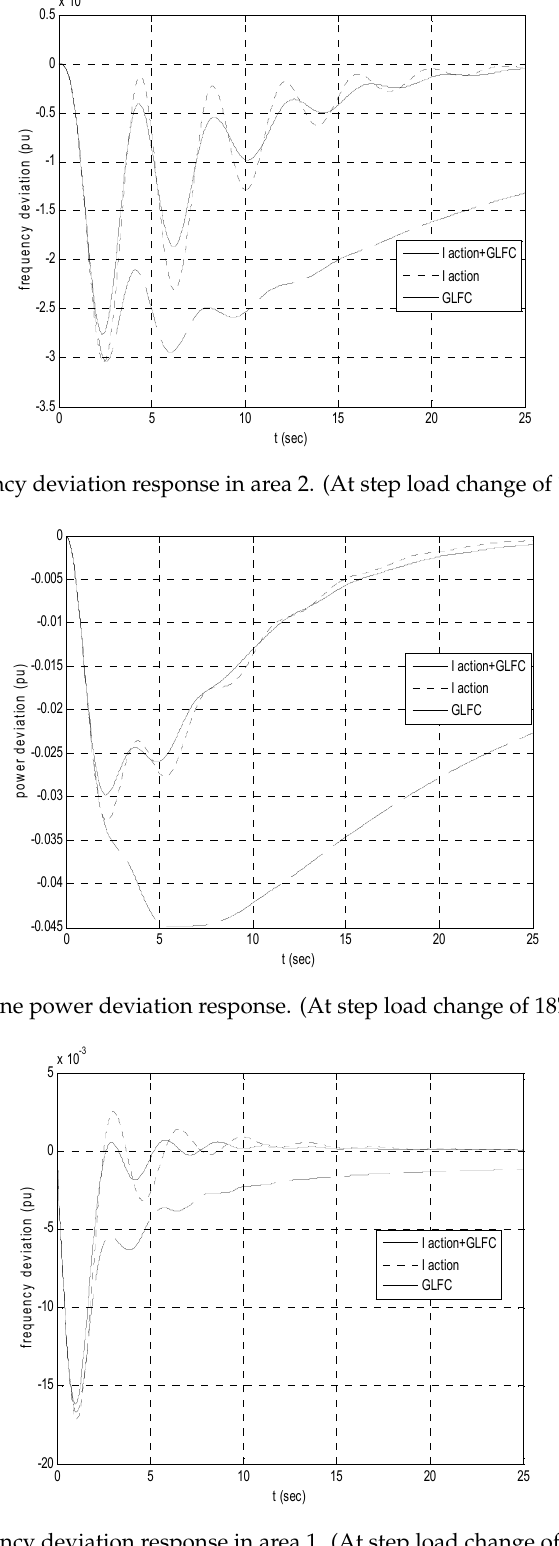
Figure 8. The frequency deviation response in area 1. (At step load change of 250 MW in area 1.